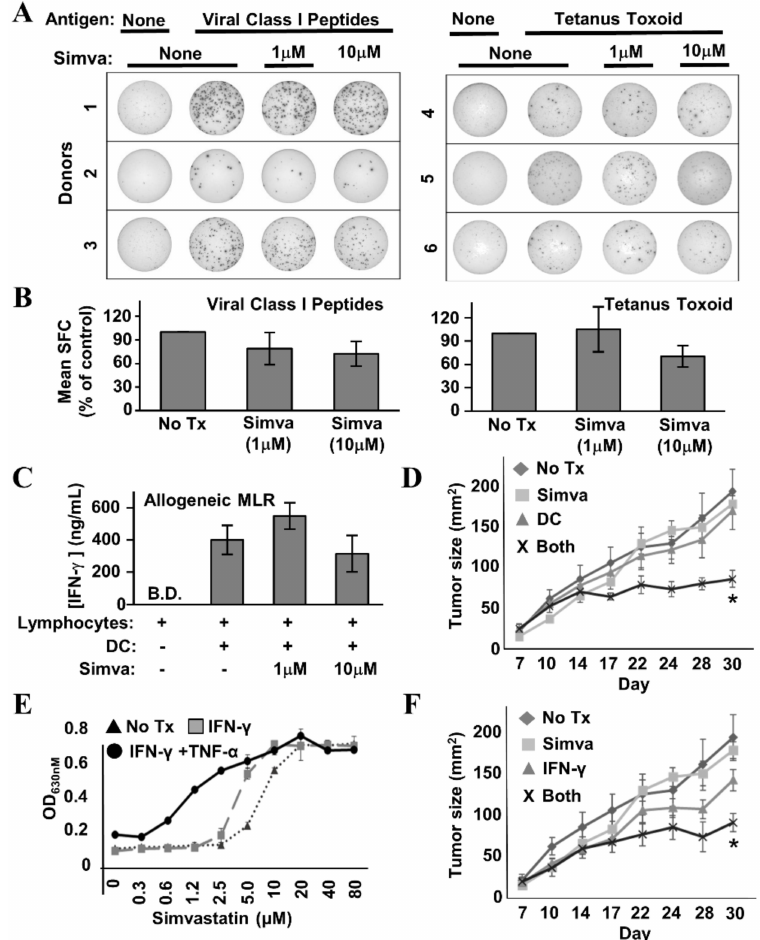
Figure 8. Simvastatin does not interfere with T cell function and enhances e ff ects of immunotherapy in a mouse model of HER-2 pos breast cancer. ( A ) Example IFN- γ EliSpot wells from individual healthy donor Peripheral Blood Mononuclear Cells (PBMCs) stimulated with a mixture of common viral peptide recall antigens (left panel) or tetanus toxoid (right panel) in the presence or absence of simvastatin (“Simva”; 1–10 µ M). ( B ) Composite analysis of each of the 3 donors for viral recall peptides (left panel) and 3 donors for tetanus toxoid (right panel). Statistical analysis by one-way ANOVA indicated no significant di ff erence between simvastatin-treated and untreated groups. ( C ) IFN- γ ELISA analysis of 72 h culture supernatants from allogeneic Mixed Leukocyte Reactions (MLRs) where activated dendritic cells (DC) and lymphocyte-rich elutriation fractions were co-cultured at 1:40 stimulator:responderratiosinthepresenceorabsenceof1–10 µ Msimvastatin. Datadisplayedrepresents the mean IFN- γ production from seven unique allogeneic DC:lymphocyte pairings. Statistical analysis by one-way ANOVA indicated no significant di ff erence between simvastatin-treated and untreated groups (B.D. = below detection). ( D ) TUBO-bearing Balb / c mice, 7 days after implantation, were either left untreated (“No Rx”) or treated with Simvastatin (“Simva”), peptide-pulsed DC-based therapy (“DC”), or given combined treatment with simvastatin plus peptide-pulsed DCs (“Both”). Tumor size was measured periodically with calipers during treatment. Tumor size denoted as average area +/ − SEM. Statistical significance is indicated by the asterisk (*). ( E ) TUBO cells were cultured in vitro with IFN- γ plus TNF- α , IFN- γ only, or no treatment in the presence of increasing concentrations of Simvastatin for 72 h, then assessed for metabolic activity by the Alamar Blue dye assay. ( F ) TUBO-bearing Balb / c mice, 7 days after implantation, were either left untreated (“No Rx”) or treated with Simvastatin (“Simva”), Interferon- γ (“IFN- γ ”) or given combined treatment with simvastatin plus IFN- γ (“Both”). Tumor size was measured periodically with calipers during treatment. Tumor size denoted as average area +/ − SEM. Statistical significance is indicated by the asterisk